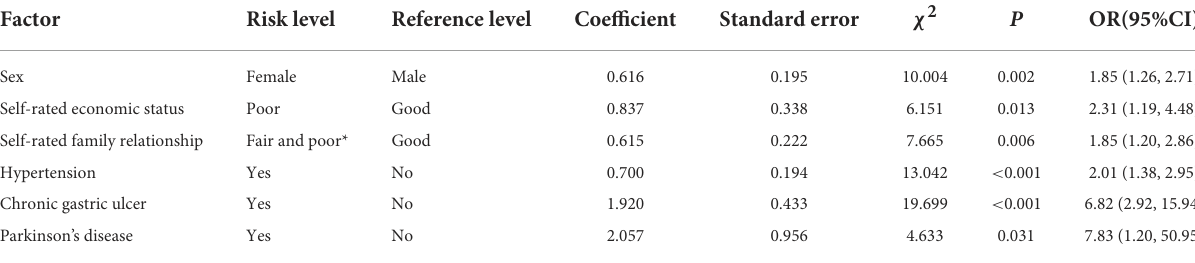
TABLE 2 Correlates of anxiety symptoms in older adults in primary care settings.